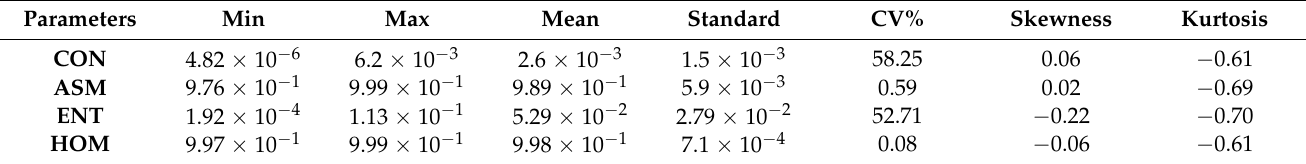
Table 4. Statistical description of four GLCM texture features of cracked soil